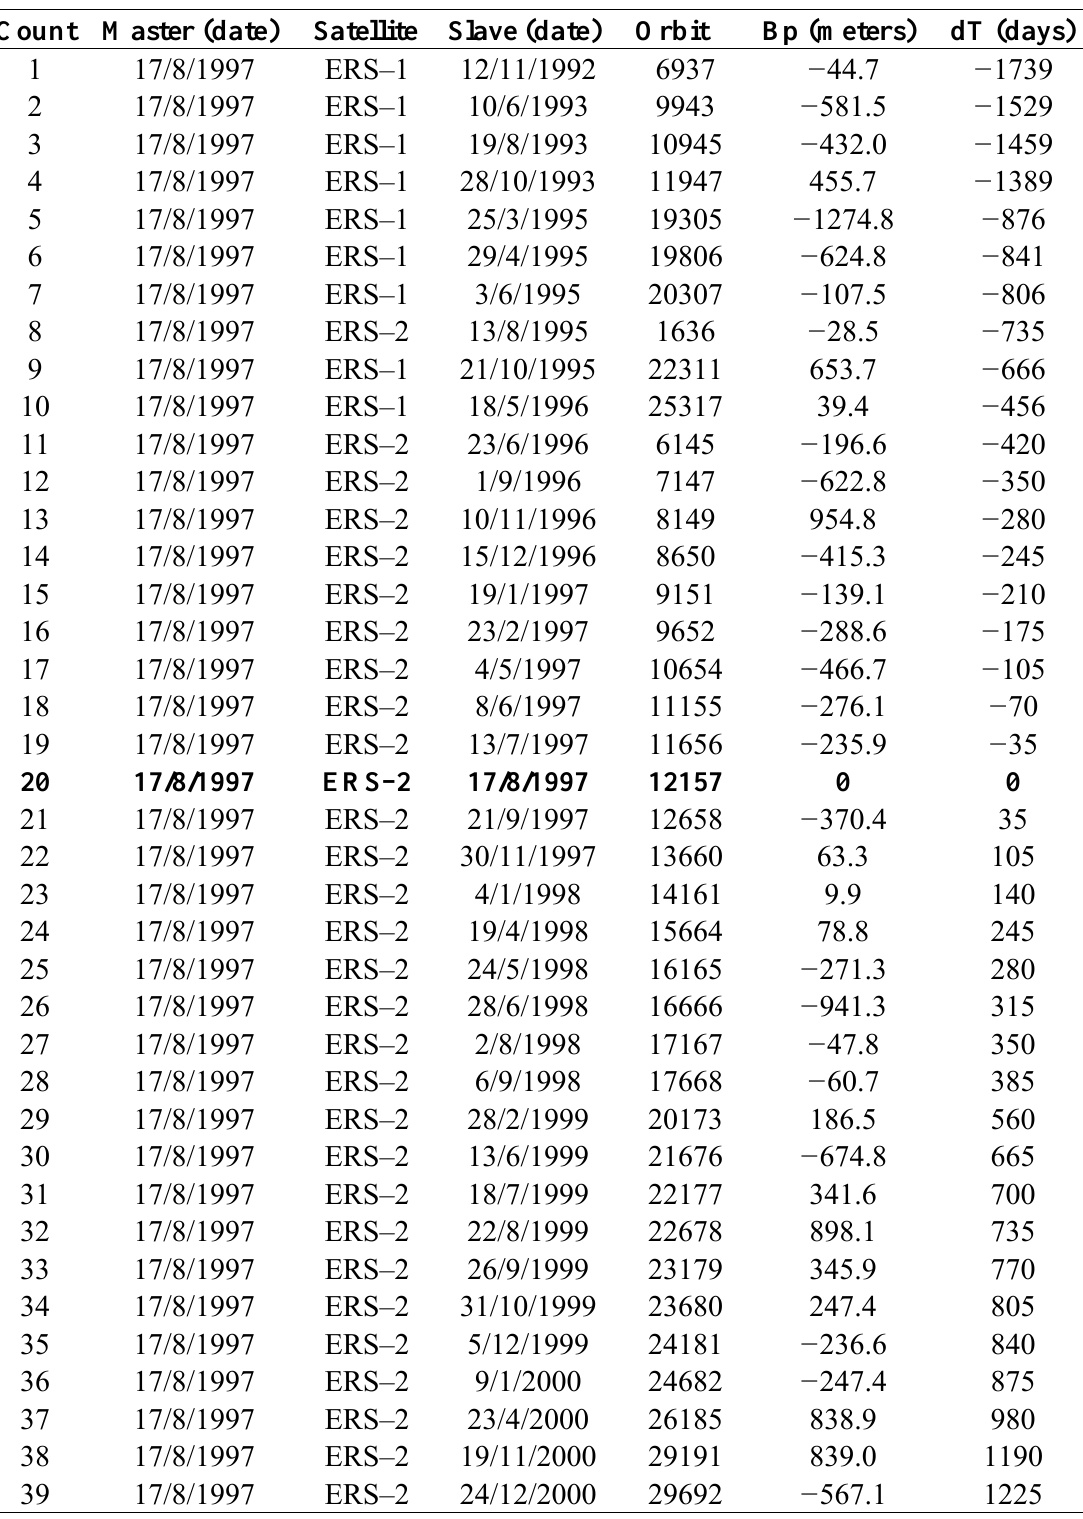
Table 2. ERS–1 & 2 scenes (Track = 279, Frame = 2846) that have been used (in bold the master reference